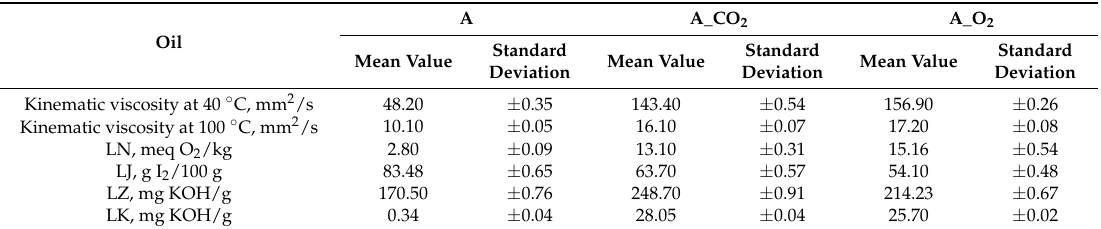
Table 1. Analytical figures for the starting material (raw Abyssinian oil (A)) and the oil modified in the presence of the solvent (A_CO 2 ) and in oxygen atmosphere, without solvent (A_O 2